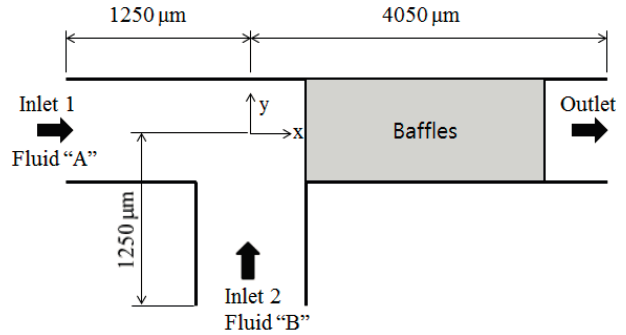
Figure 1. Schematic diagram of a T-shaped micro-channel.